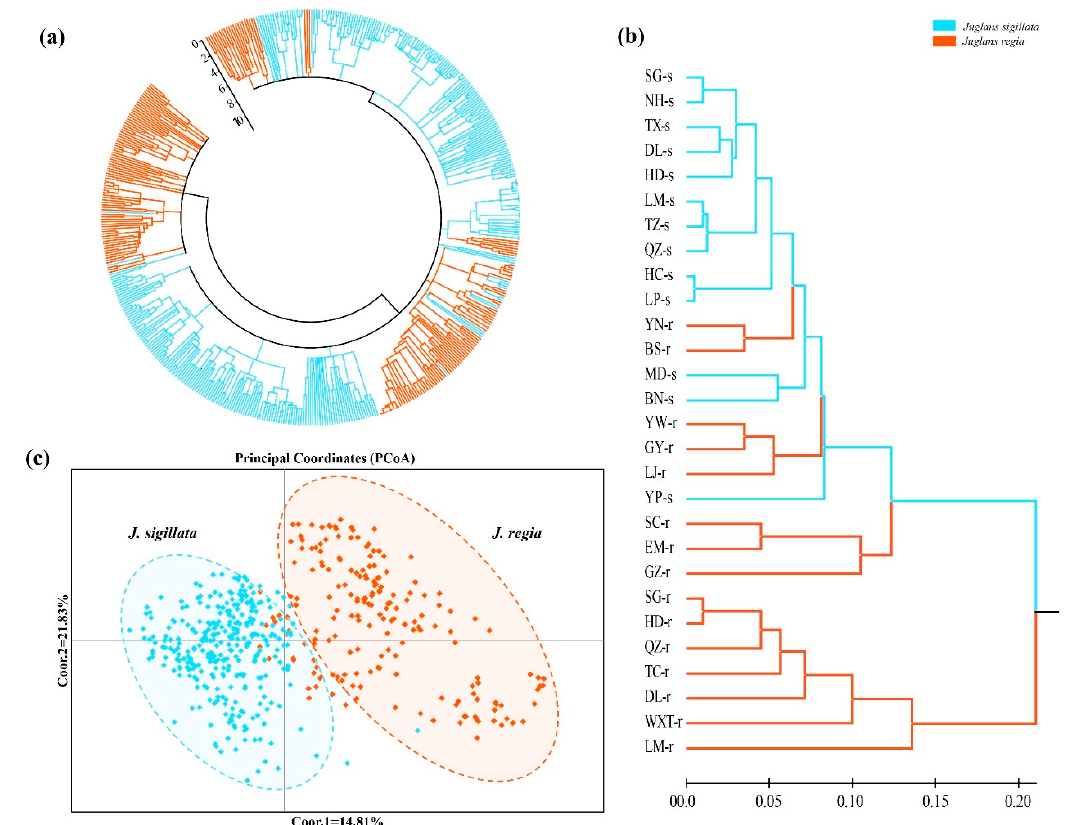
Figure 3. ( a ) Dendrogram generated by NJ cluster analysis of 506 individuals of J. regia and J. sigillata and ( b ) UPGMA cluster analysis of 28 Juglans populations (comprising of 15 J. regia and 13 J. sigillata ) based on Nei’s unbiased genetic distances. The letter “s” at the end of a population name indicates J. sigillata and “r” refers to J. regia . ( c ) Principal coordinates analysis ( PCoA ) of 506 individuals of J. regia and J. sigillata based on EST-SSR (25 loci). Each species is labeled with a different color, highlighting the existence of two distinct clusters.